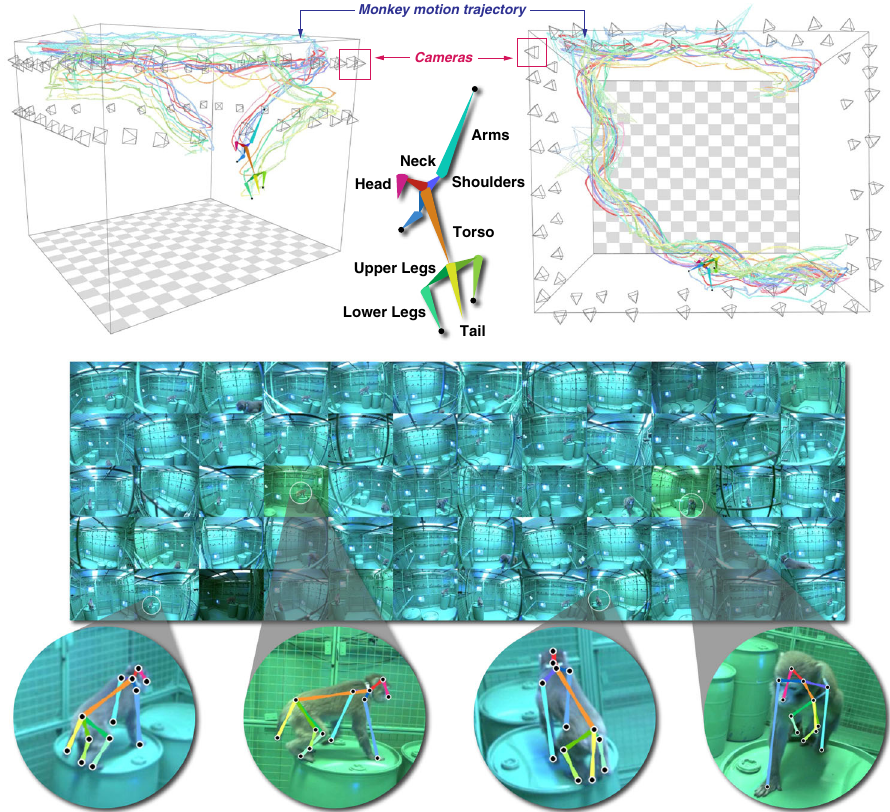
Fig. 2 Representative tracking results. A markerless motion capture system called OpenMonkeyStudio is designed to reconstruct 13 body landmarks in 3D. The system with 62 cameras that encircle a large open space synchronously captures a macaque ’ s movement from diverse vantage points. Colored traces correspond to joint labels. The multiview images and four arbitrary cropped images superimposed with the projection of the reconstruction are